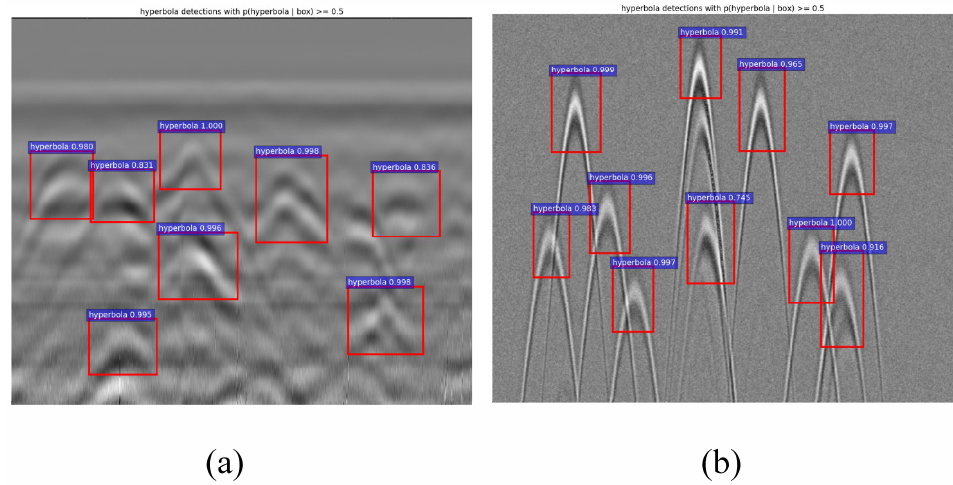
Figure 15. Results of hyperbola detection by Faster RCNN. ( a ) Results of hyperbola detection on an on-site B-Scan image. ( b ) Results of hyperbola detection on a simulated B-Scan image.